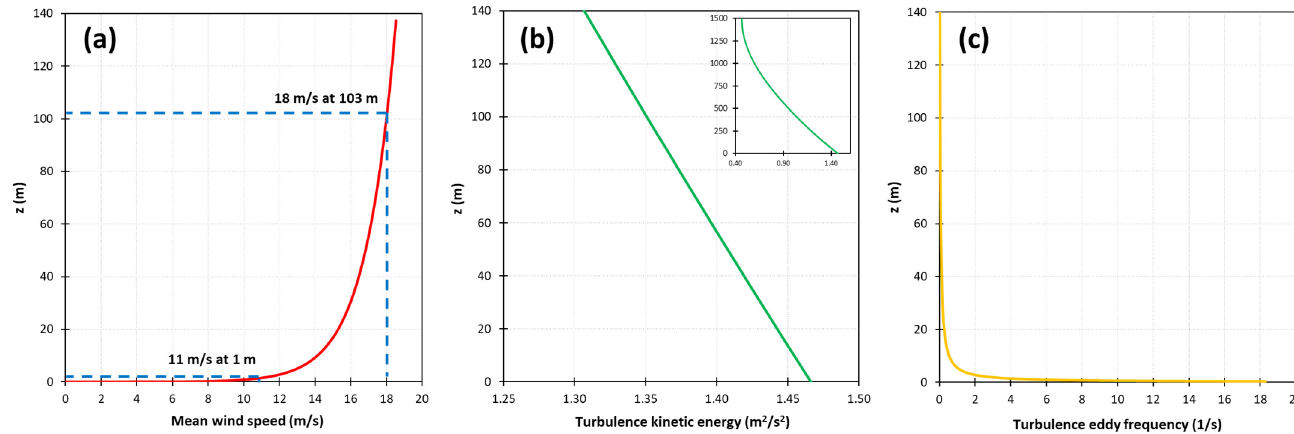
Figure 3. Mean ( a ) and gust ( b ) wind speed time series outputs of the 333 m model upstream of the Auckland Harbour Bridge, during the extreme westerly event on 18 September 2020.